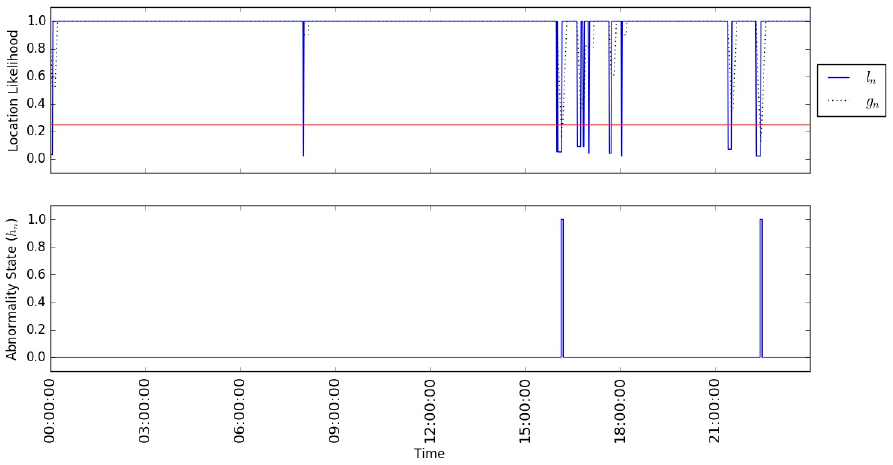
Figure 4. Estimator’s results (smoothed and classified) synthetic dataset (user Profile A).